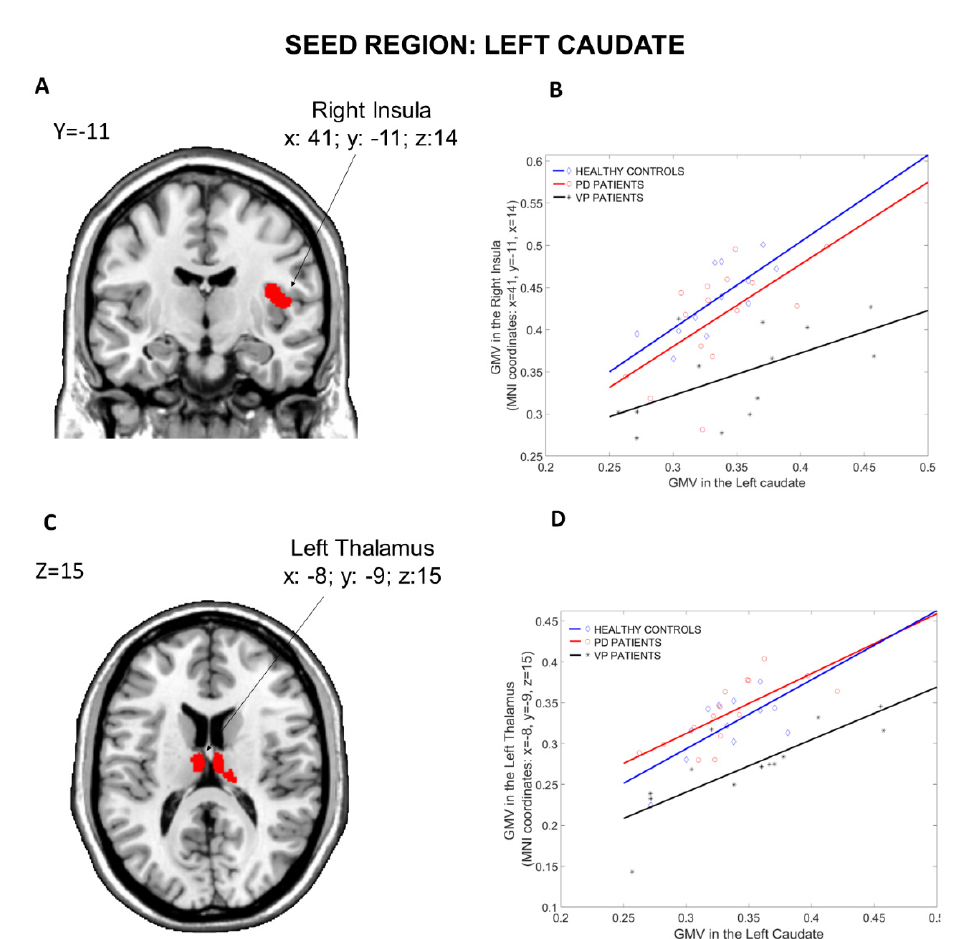
Figure 3. Group differences in the structural covariance of the Left Caudate. Brain maps are displayed using the neurological view. Panel ( A ): Voxels of the Right Insula that expressed differences in the structural association across the three groups. Panel ( B ): Correlations between the mean gray matter volume of the Left Caudate and the regional gray matter volume extracted from a 4 mm- radius sphere centered on the peak voxels of the significant cluster (x: 41, y = − 11, z: 14). Panel ( C ):